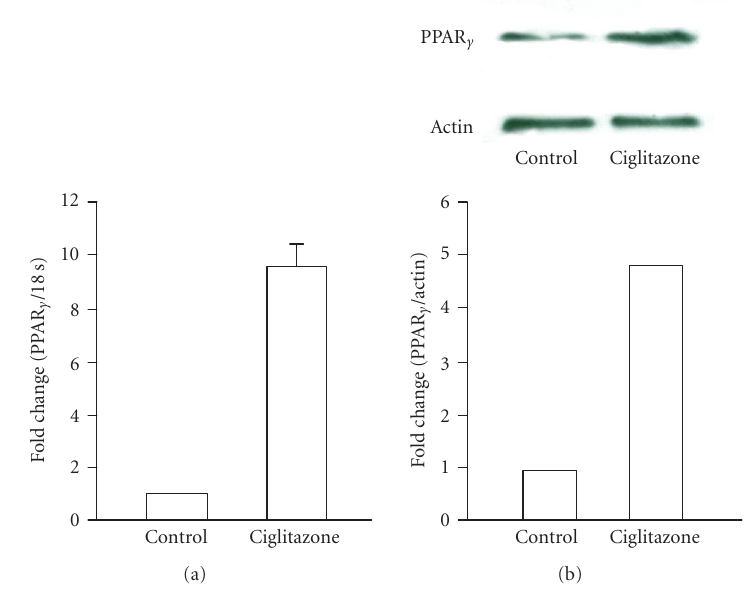
Figure 1: Ciglitazone promotes PPAR γ expression in the growth plate chondrocytes. Growth plate chondrocytes in pellet cultures were incubated in the presence or absence of 5 μ M of ciglitazone for 4 days. (a) Total RNA was collected and real-time PCR was performed to quantitate PPAR γ mRNA levels, which were normalized with respect to endogenous 18S rRNA levels. (b) Proteins were extracted for immunoblotting to detect PPAR γ expression and the immunoblots quantitated using Kodak 1D image analysis software. Actin was used as an internal control.